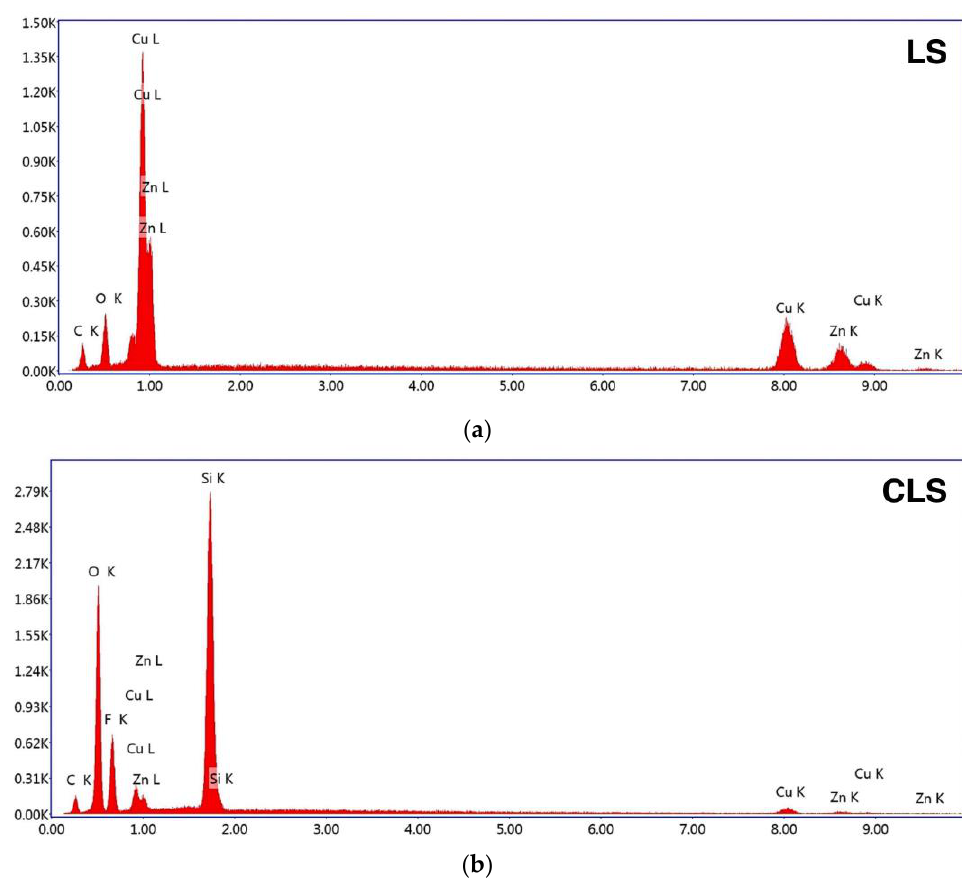
Figure 5. EDS spectrum of ( a ) LS and ( b ) CLS.